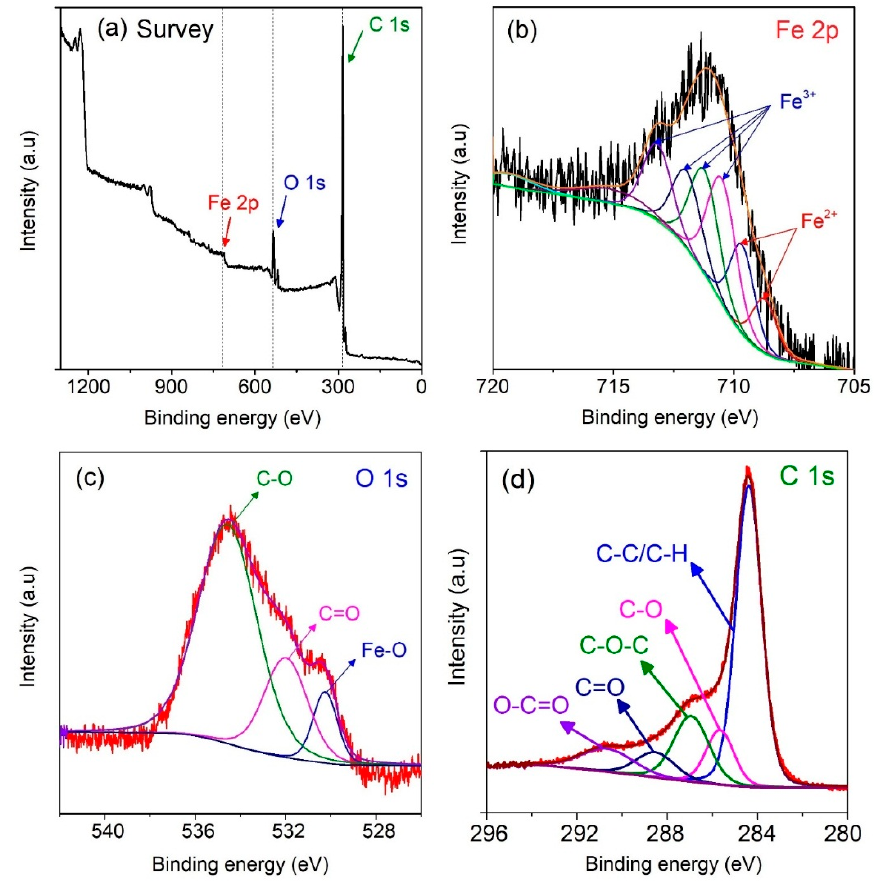
Figure 4. The XPS spectrum of MPC700 material: survey ( a ); Fe 2p ( b ); O 1s ( c ), and C 1s ( d ). Table 3. Surface groups obtained from Boehm titration of Fe 3 O(BDC) 3 and MPC700.